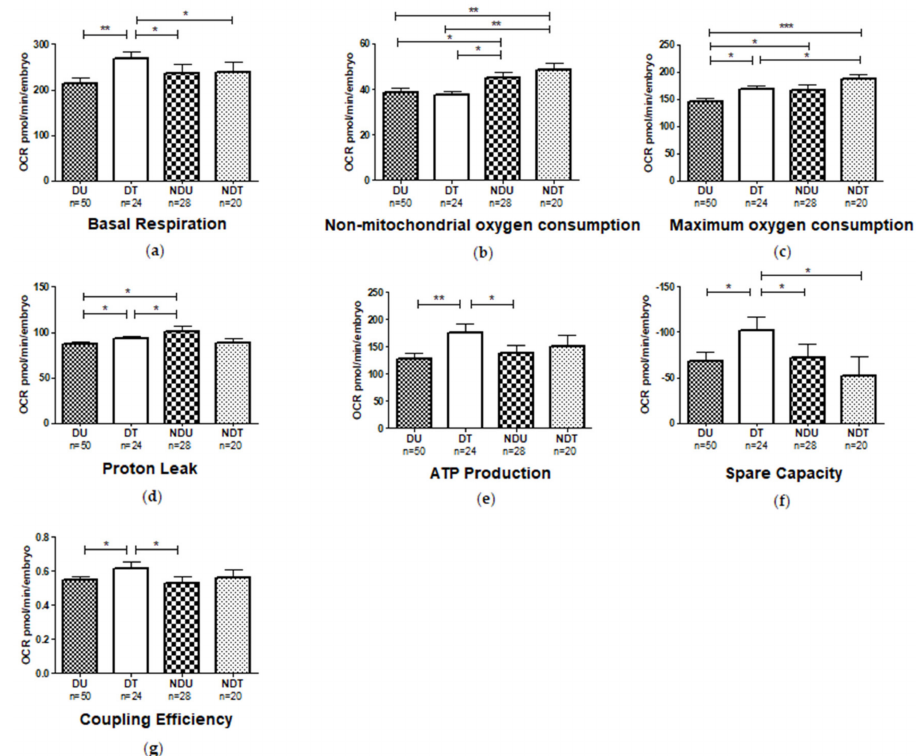
Figure 10. Mitochondrial respiratory analysis of Dystrophic Untreated (DU), Dystrophic Treated (DT), Non-dystrophic Untreated (NDU), Non-dystrophic Treated (NDT): ( a ) Basal respiration; ( b ) Non-mitochondrial oxygen consumption; ( c ) Maximum oxygen consumption; ( d ) Proton Leak; ( e ) ATP Production; ( f ) Spare respiratory capacity; ( g ) Coupling efficiency. Data are given as mean and standard error (* p ≤ 0.05, ** p ≤ 0.01, *** p ≤